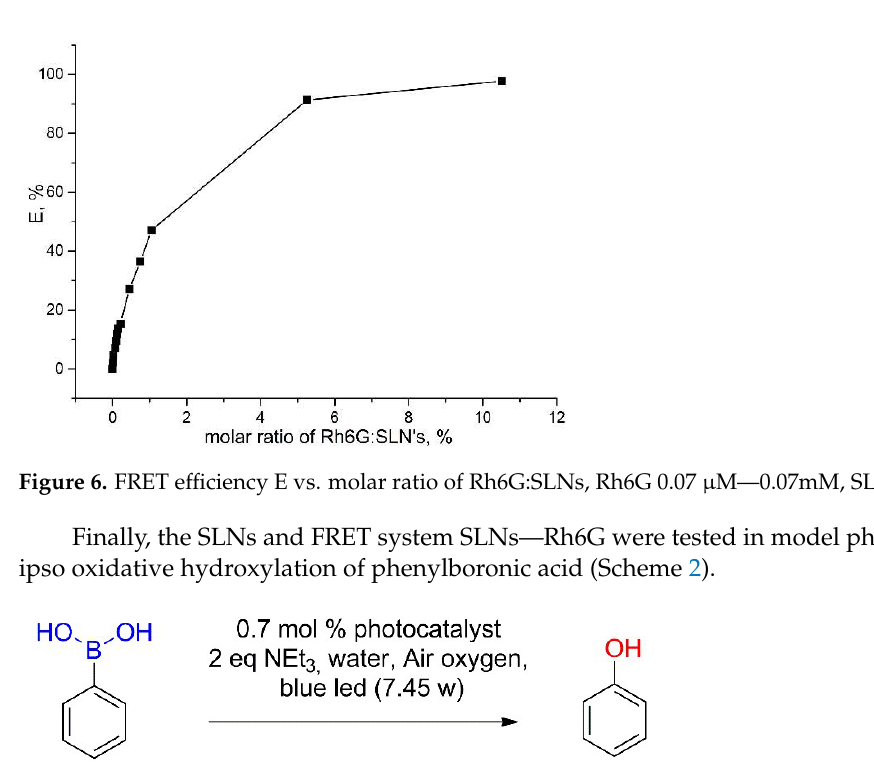
Scheme 2. Photoredox hydroxylation of phenylboronic